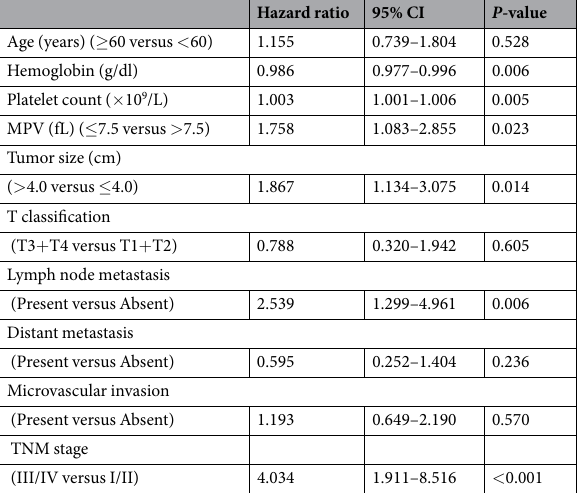
Hazard ratio 95% CI P -value